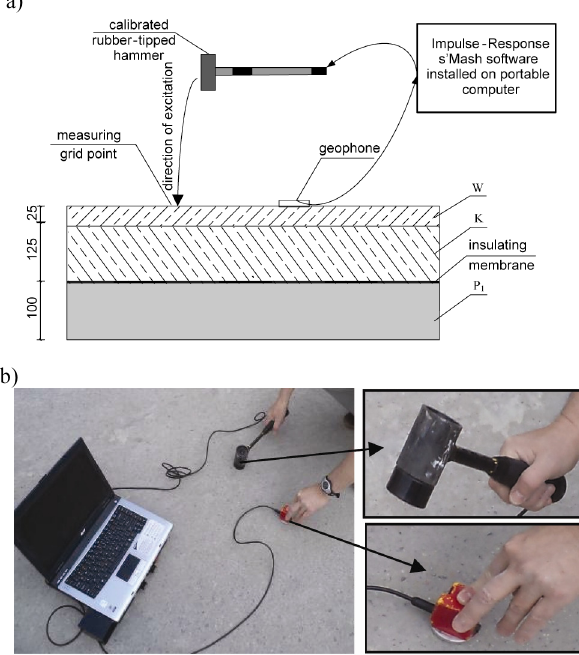
Fig. 5. Schematic of impulse-response test rig (a), and actual testing (b)